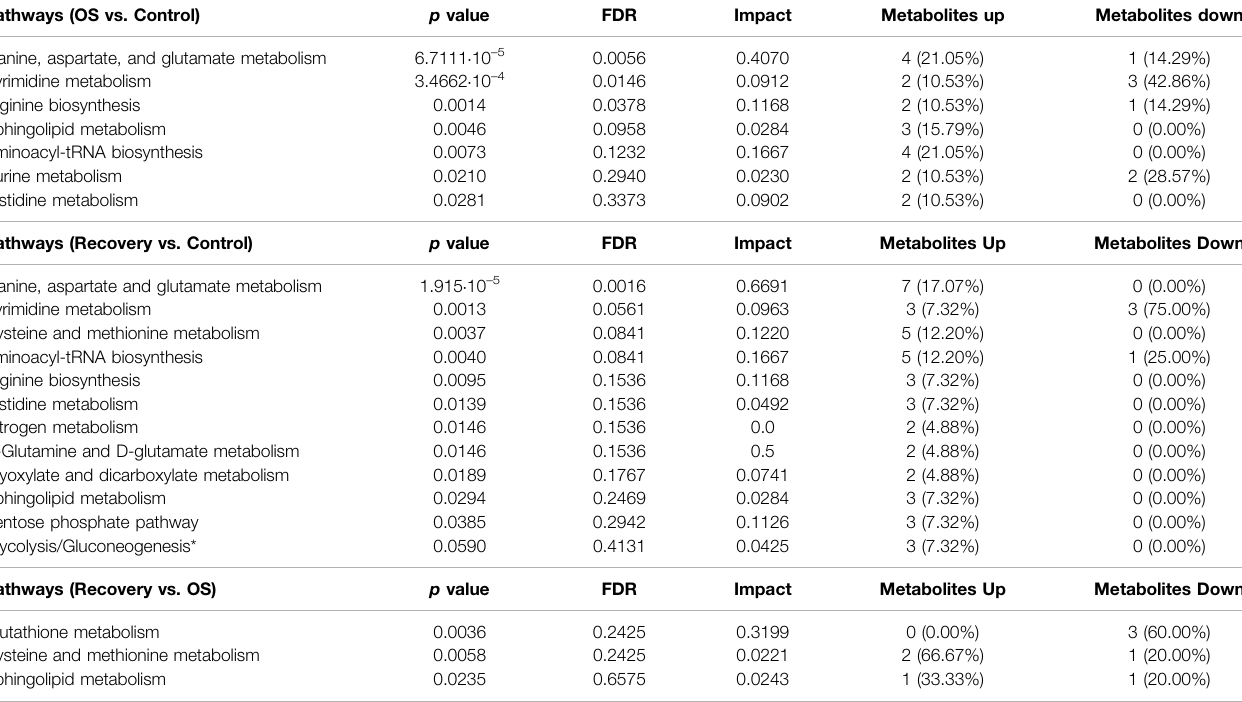
TABLE 3 | Statistically signi fi cant metabolic pathways ( p value < 0.05) altered in H9c2 cardiomyocytes upon H 2 O 2 -induced oxidative stress. * p value < 0.01. Pathways (OS vs.